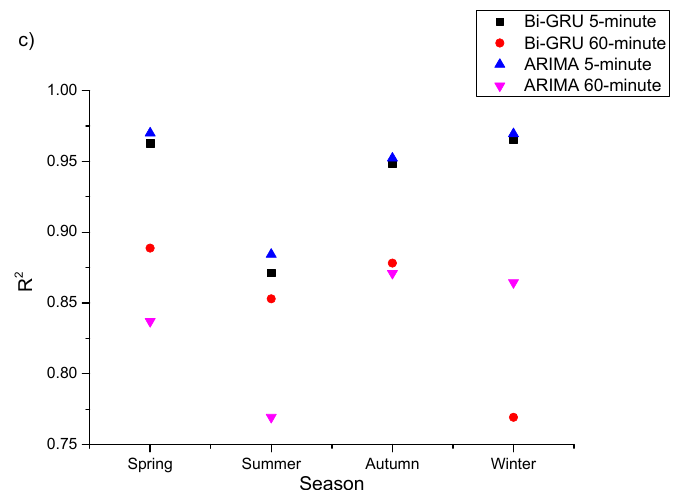
Figure 6. Average seasonal variations in solar irradiance predictions ( a ) RMSE levels, ( b ) MAE levels, ( c ) R 2 levels. Table 6. Time consumed in training and testing of the single models. Time Consumed by Bi-GRU (s) Time Consumed by ARIMA (s)